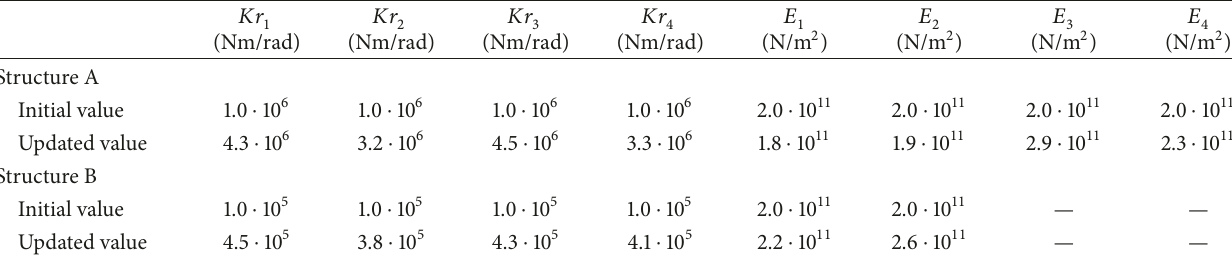
Table 4: Initial and updated values of FE model parameters.